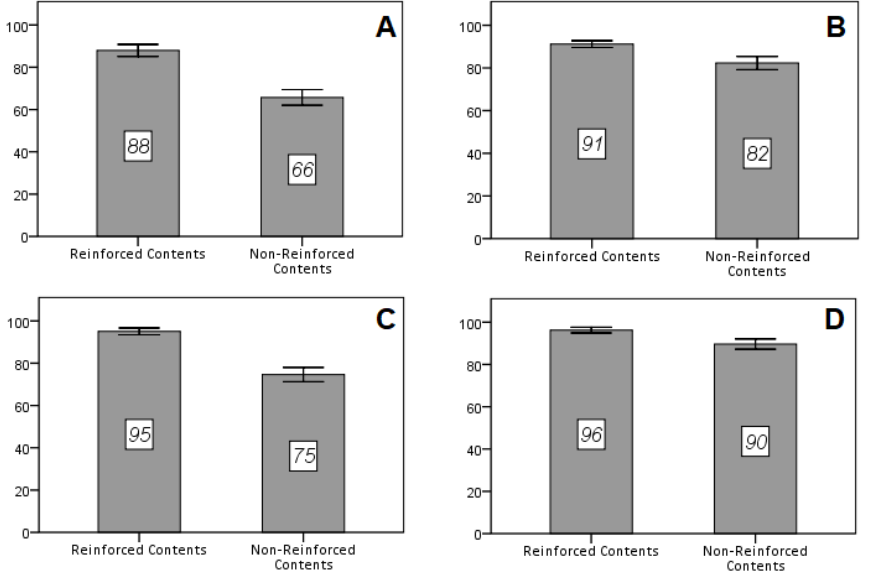
Figure 3. Percentages of correct answers in the final exam of ( A ) Physiotherapy Fundamentals; ( B ) Kinesitherapy; ( C ) Special Massage Therapy and ( D ) Abdominopelvic Physiotherapy subjects. Reinforced contents vs. non-reinforced contents.